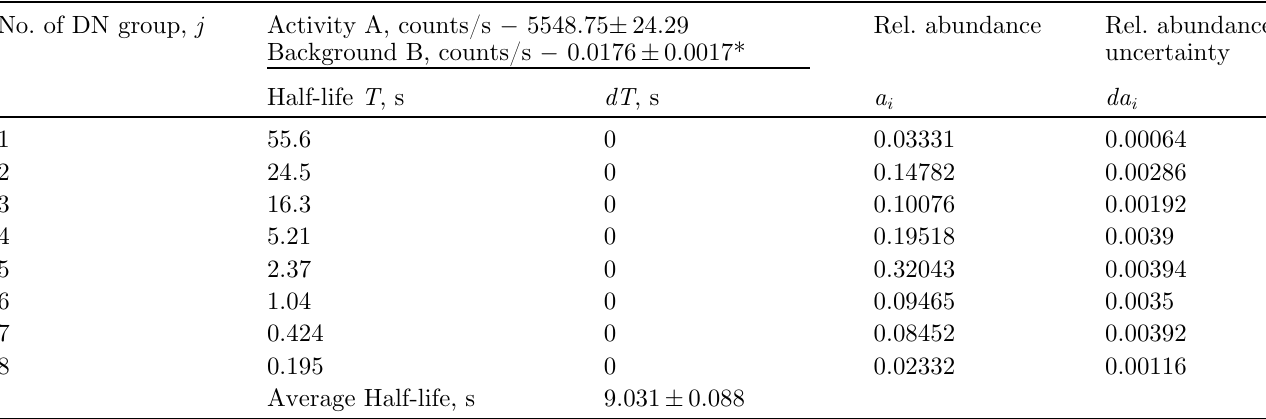
Table 4. The 8-group DN parameters ( a the estimated 6-group DN